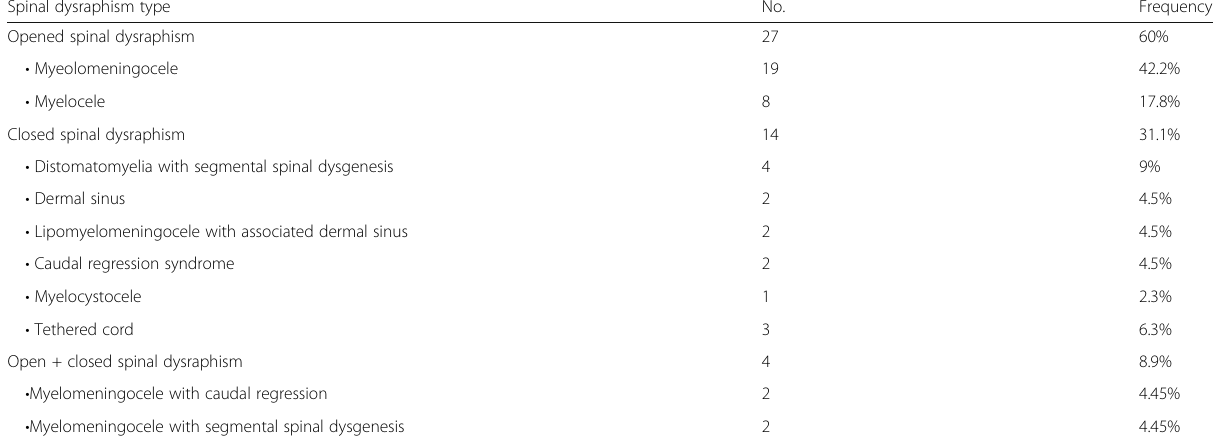
Table 2 Detailed distribution of study population in terms of different types of spinal dysraphism Spinal dysraphism type No.